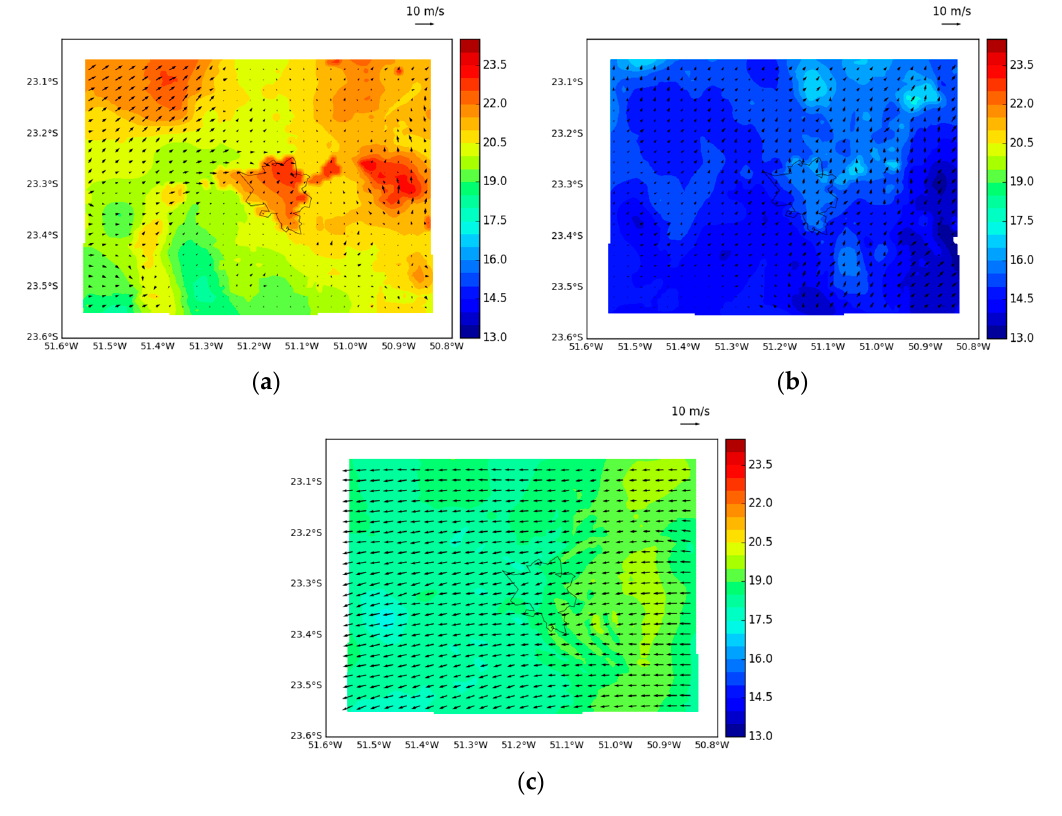
Figure 6. Air temperature at 2 m (in °C) for 18 Z at 22 July 2015 for simulation with ( a ) SRESA2; ( b ) SRESB1 and ( c ) GFS simulations. Black arrow is the wind velocity intensity at 10